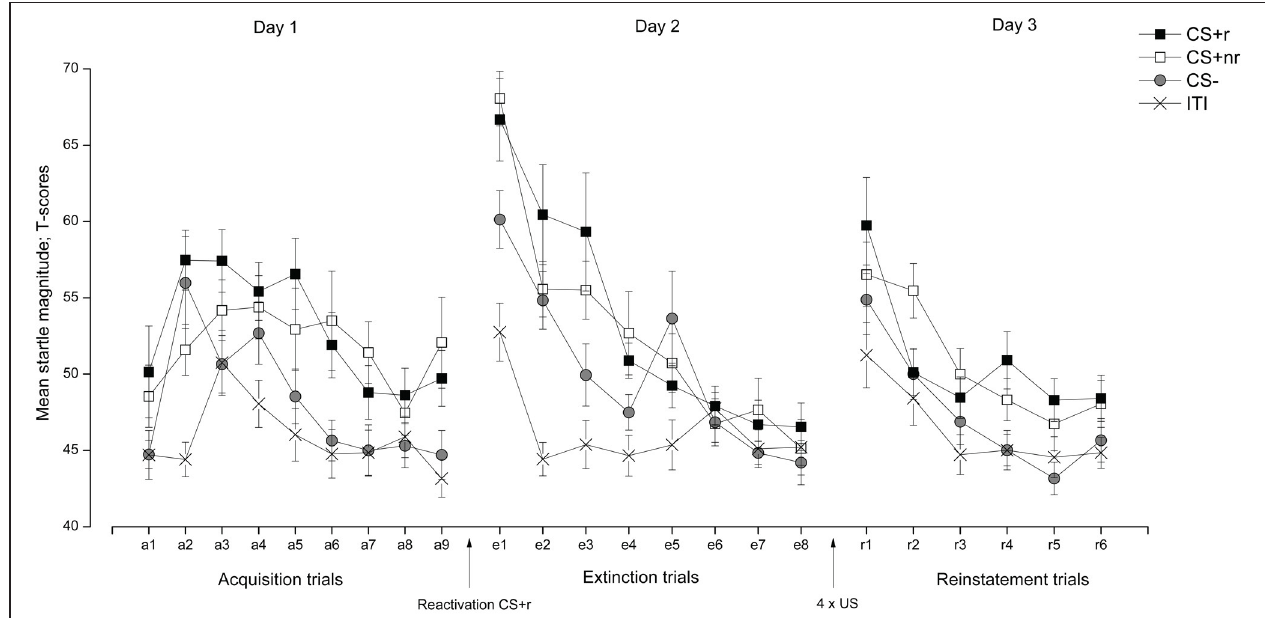
acquisition, extinction, and reinstatement testing. We did not observe any effects of fear memory reactivation (CS + r) prior to extinction learning on fear potentiated startle. Error bars represent standard error of the mean (SEM). Note that we did not present any startle probes during the reactivation